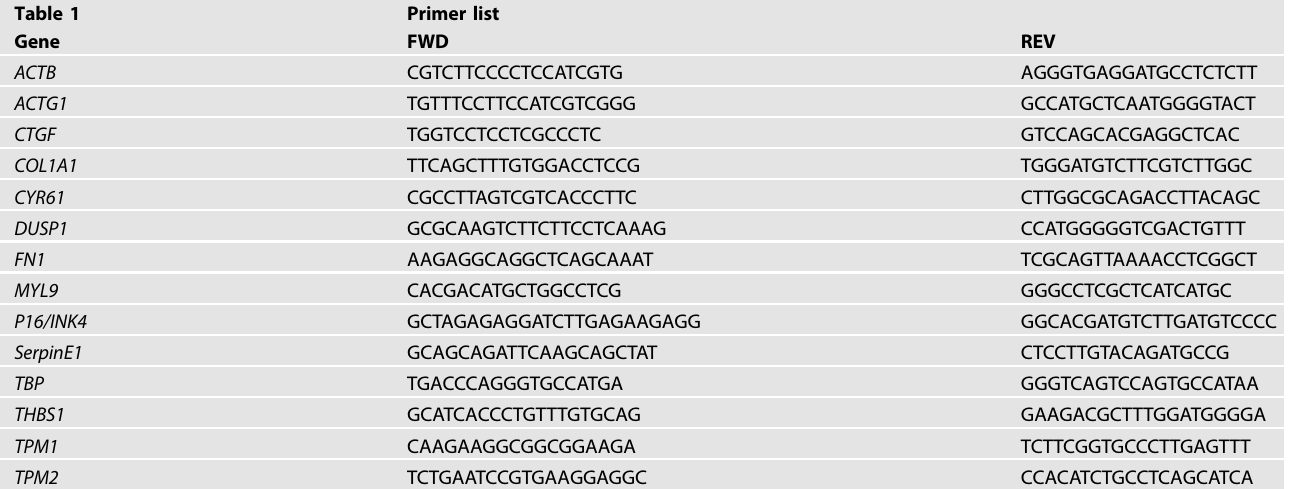
Table 1. Primers for qPCR. Table